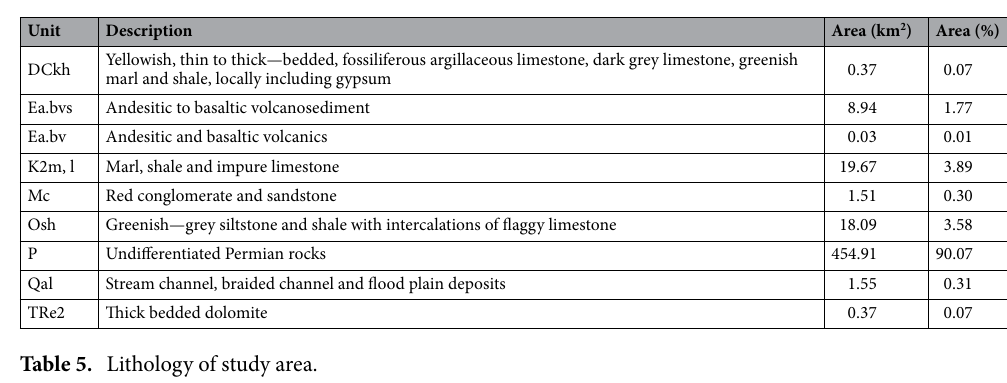
Table 5. Lithology of study area.